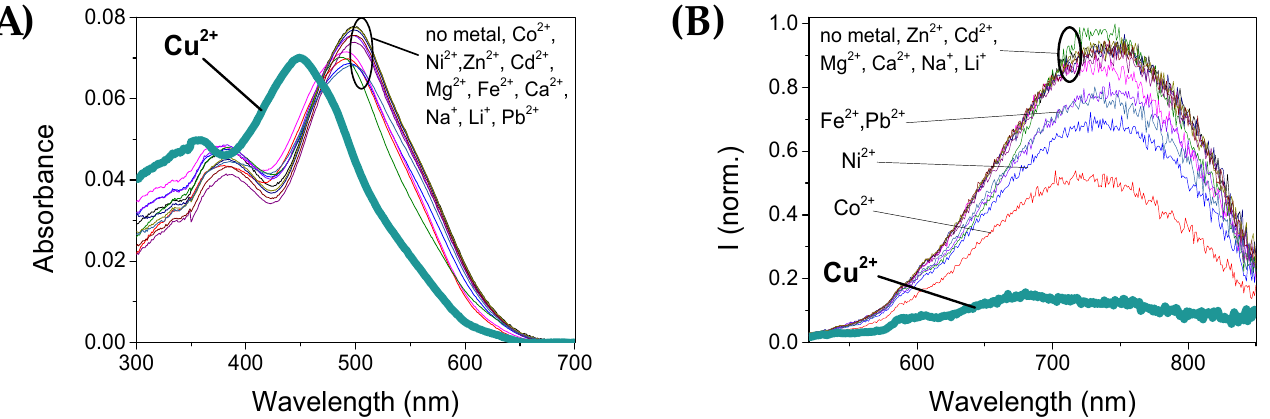
Figure 3. UV-Vis ( A ) and emission ( B ) spectra of chemosensor 4 (2.5 μ M) in the presence of two equivalents of different metal ions, in a 50:50 mixture of methanol and 0.01 M HEPES buffer at pH = 7.1 ( λ EXC = 500 nm).